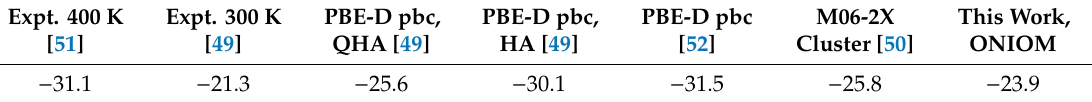
Table 1. Adsorption enthalpies (kcal mol − 1 ) of ethanol in H-ZSM-5.